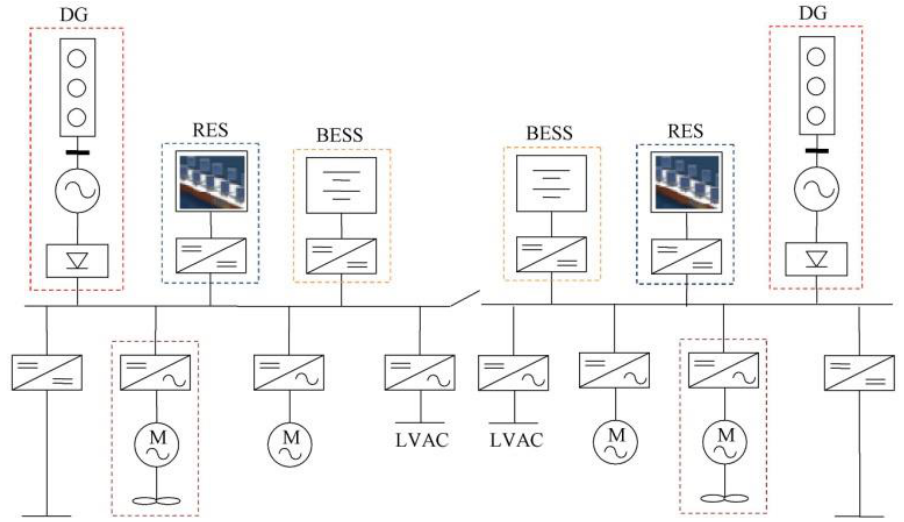
Figure 1. DC ship power system (DG: diesel generator, RES: renewable energy source, BESS: battery energy storage system, LVAC: low voltage alternating current).